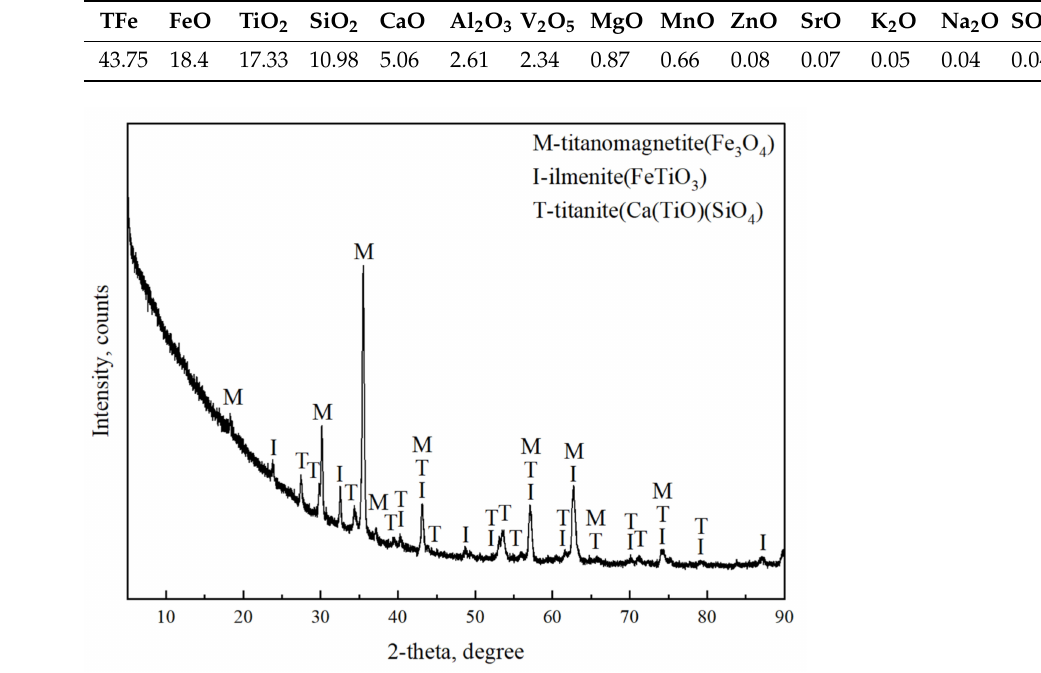
Table 1. Chemical compositions of the LVTC/mass (%).